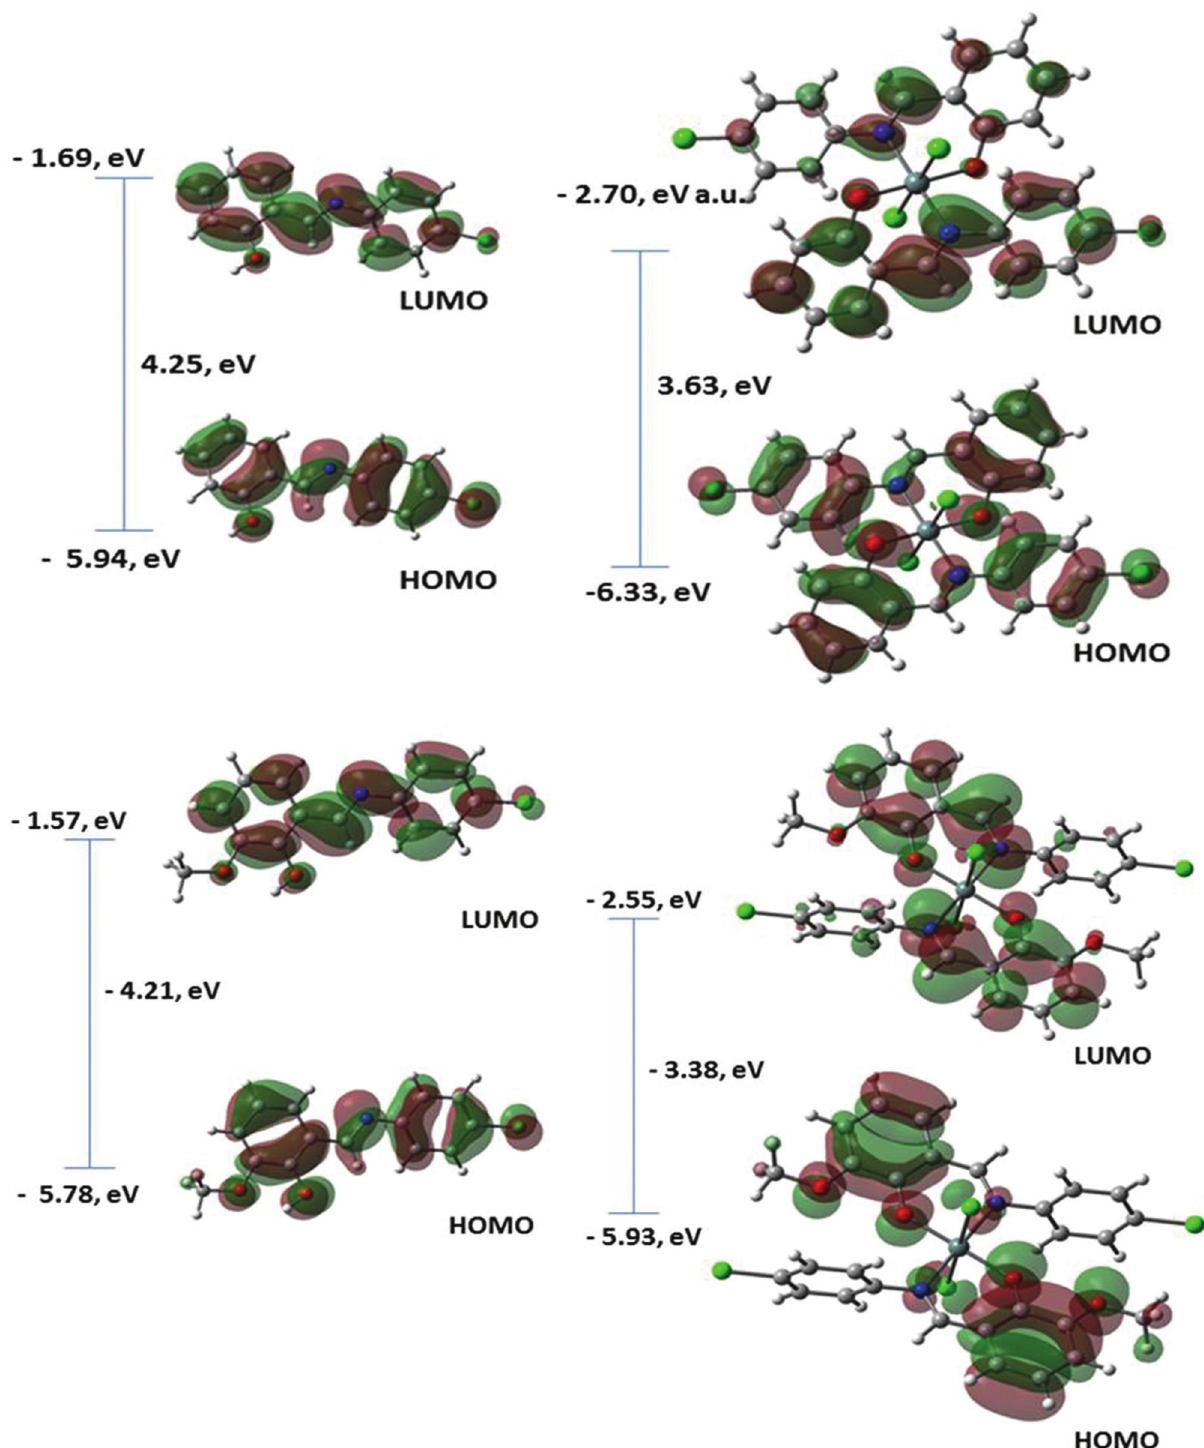
Figure 3: Energy diagram of frontier molecular orbitals HOMO and LUMO of ligand, I & III and complex, 1 & 3 derived from DFT calculations using B3LYP/LANL2DZ level of